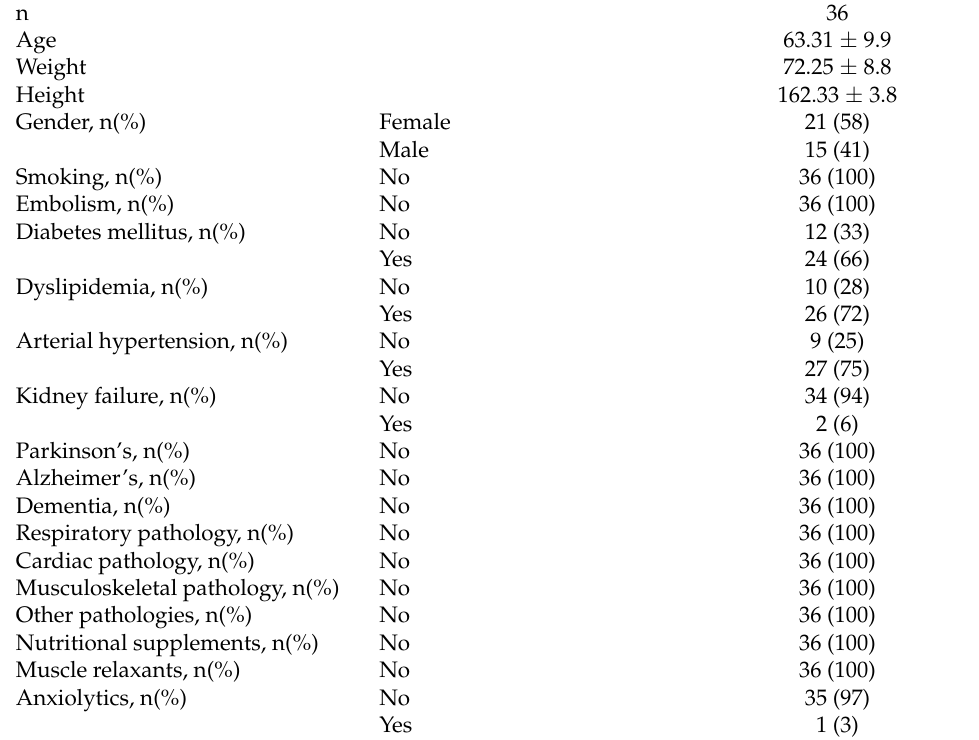
Table 1. Clinical and demographic characteristics of the